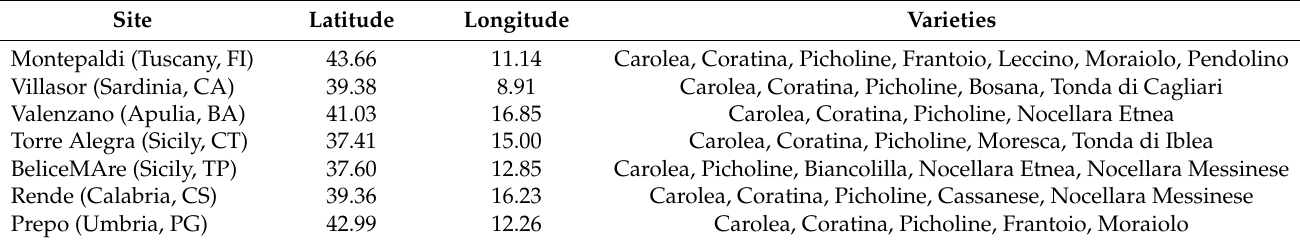
Table 1. Coordinates of experimental sites and olive varieties monitored in the PHENAGRI project. Site